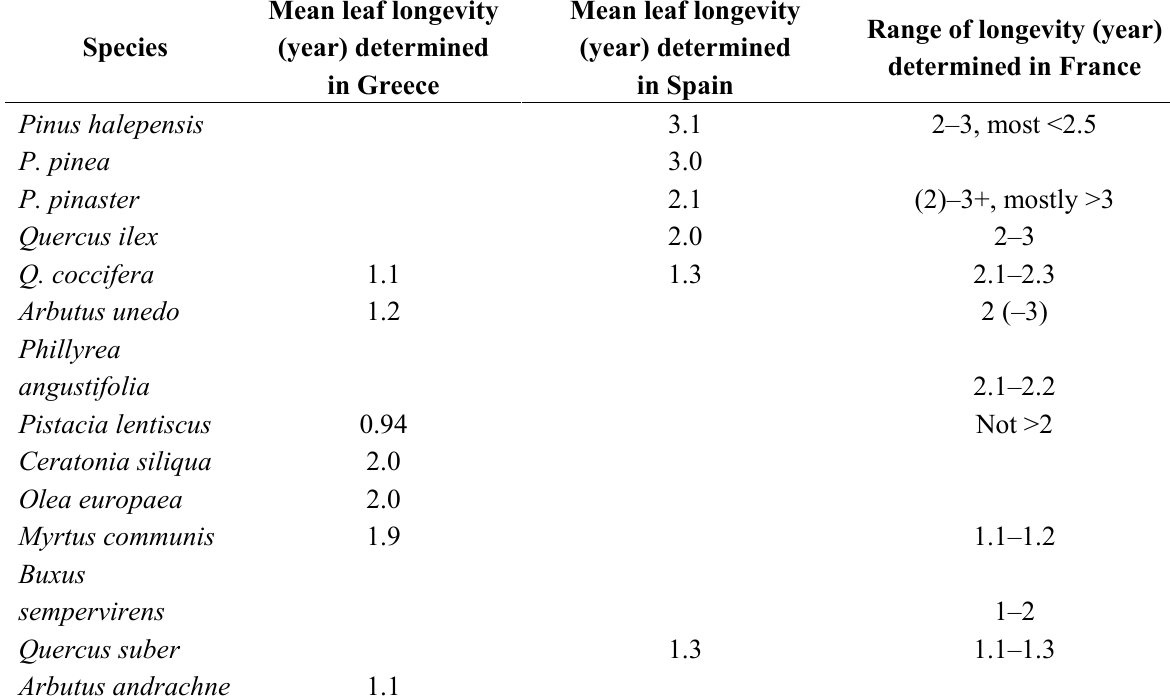
Table 2. Mean leaf longevities recorded for sclerophyll species in Greece [12], France [13] and Spain [16]; the longevities given in months in [12] and [13] have been converted to years, and all values reduced to no more than two significant